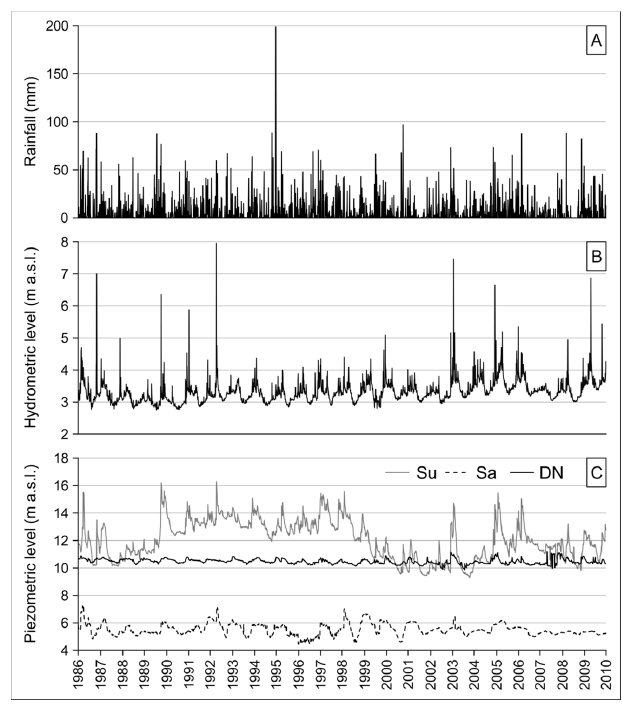
Figure 5. Rainfall ( A ); river level ( B ); and piezometric level ( C ) for 1986–2009 three-day time